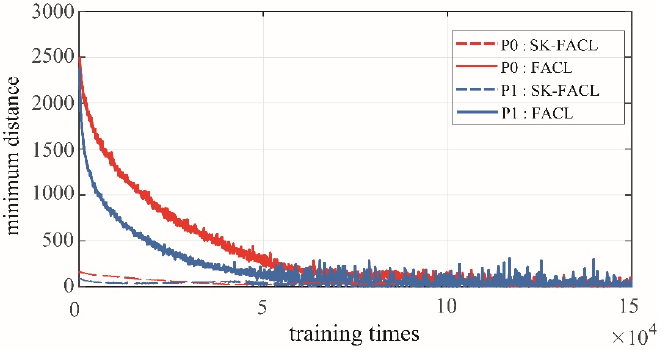
Figure 14. The traces of P 0 , P 1 and E 0 under the proposed SK-FACL with ∆ v = 30% v P .